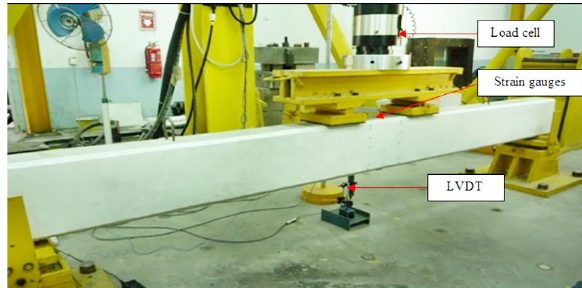
Figure 3. Instrumentation and layout of the